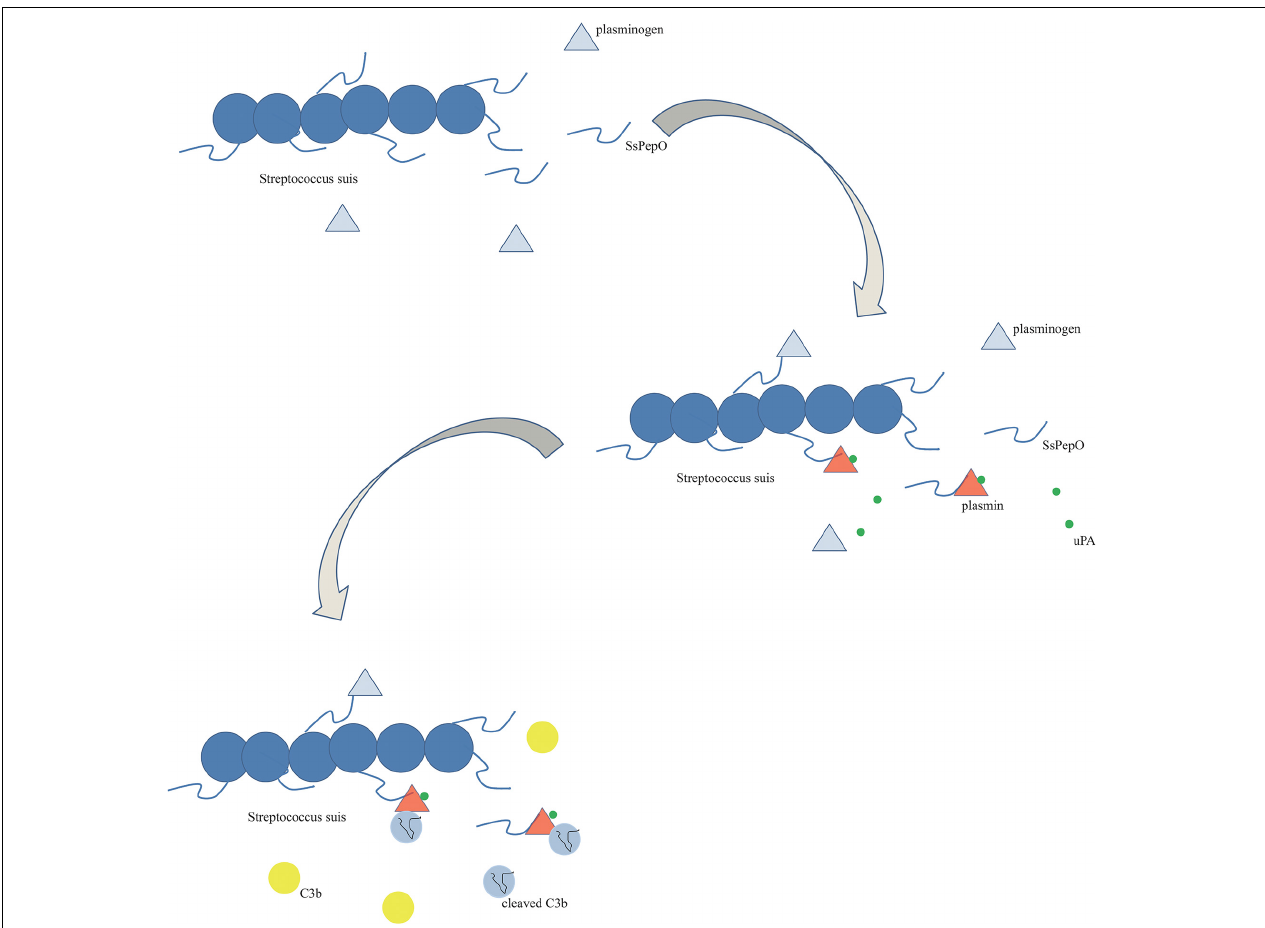
FIGURE 7 | Schematic diagram. SsPepO binds plasminogen. The binding of SsPepO and plasminogen, upon the activation of urokinase-type plasminogen activator, generated plasmin, which could cleave complement C3b.